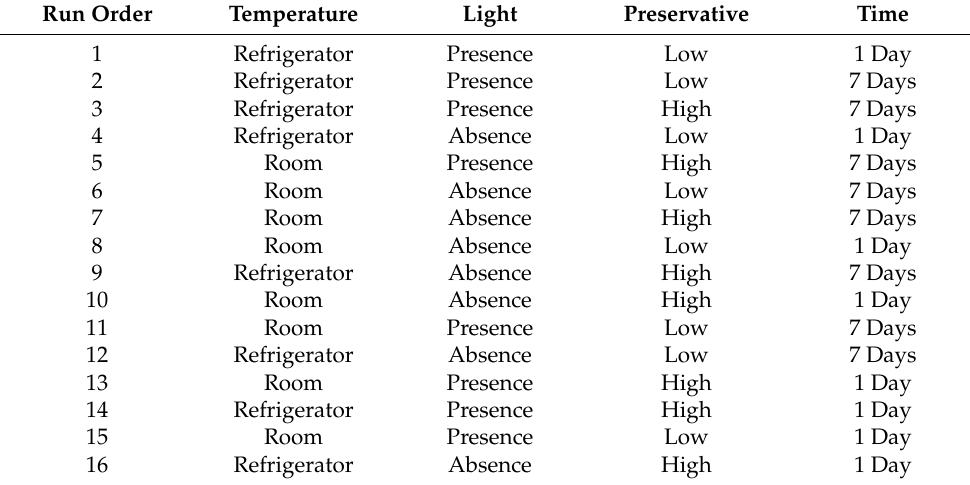
Table 1. Experimental